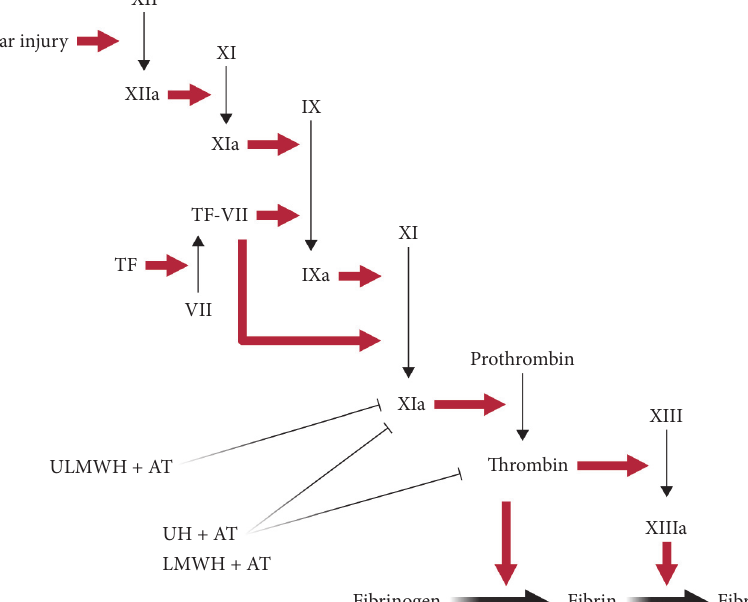
Figure 3: Main coagulation cascade reactions activated by vascular injury and heparins’